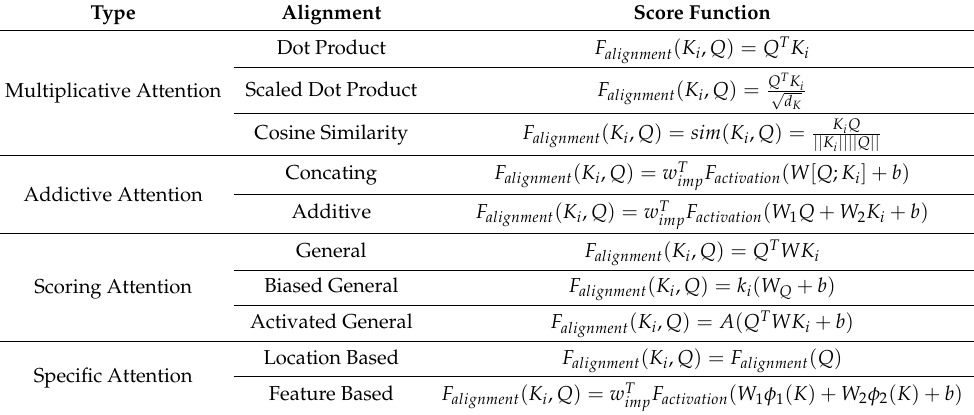
Table 1. List of common attention types used in reviewed TB models with corresponding alignment functions where sim is the measure of similarity between K i and Q vectors and || K i || and || Q || are the Euclidean norm of these vectors.